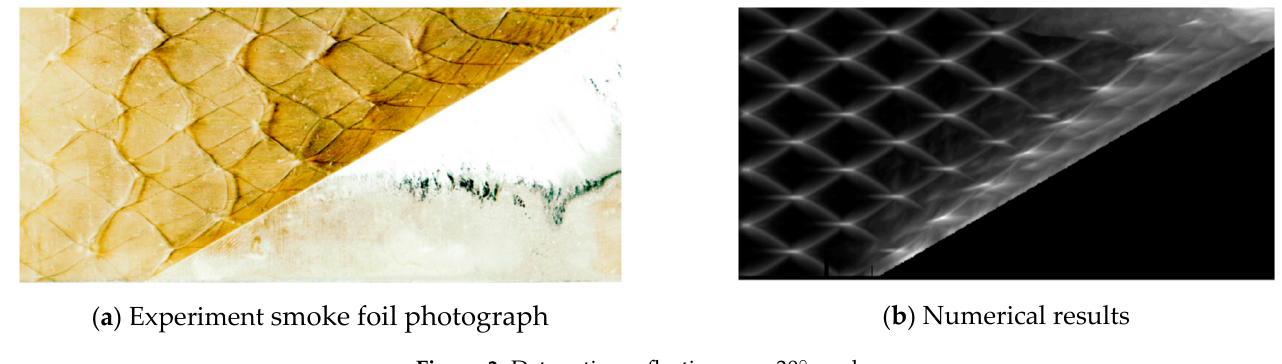
Figure 3. Detonation reflection over 30° angle.